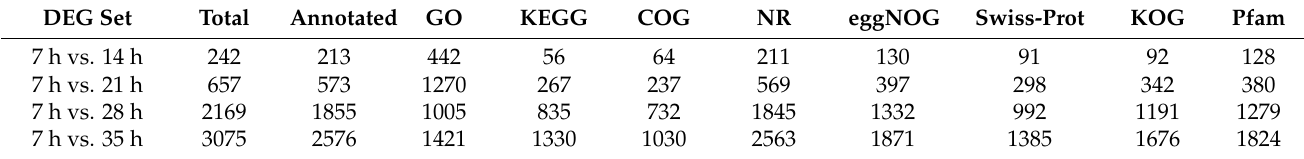
Table 2. Summary statistics of differential expression genes in different time points of deutonymph in T. urticae . DEG Set